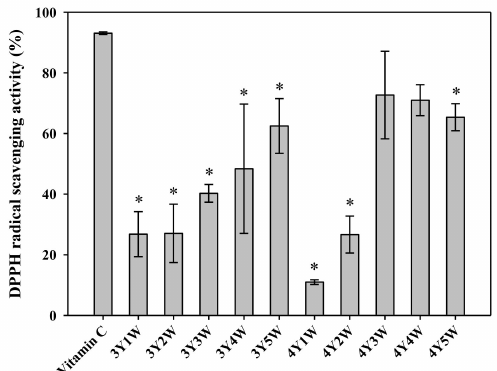
Figure 1. DPPH radical scavenging activity of ginseng berry extracts harvested at various time points. Rectangular bars and their error bars represent means and standard deviations, respectively ( n = 3). The ‘ m Y n W’ on the x-axis means m -year-old ginseng berry harvested in the n th week of July. *, significantly lower than the ‘Vitamin C’ group (positive control).